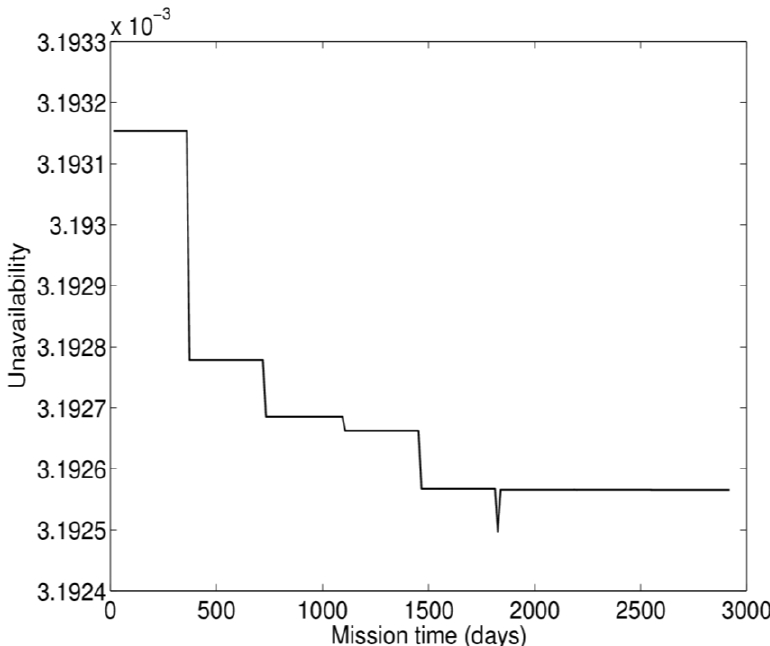
Figure 5. Unavailability evolution of system Version 1 with TP = TP max (all components). Table 3. Decision variable vectors ( TP 1 , . . . , TP k ) for the configurations of system Version 2.